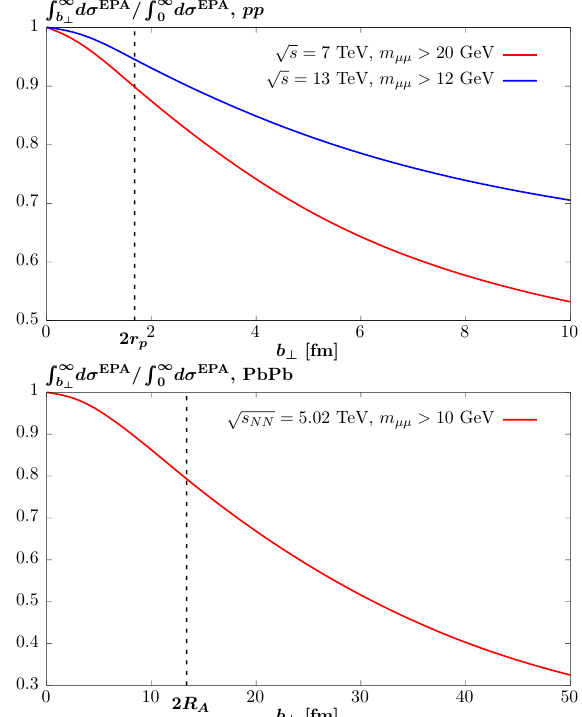
Figure 4: The pure EPA predictions for the ATLAS pp [ 14,16 ] and PbPb [ 24 ] data as a function of a lower cut on the hadron–hadron impact parameter b ⊥ , considered as a ratio to the full EPA result, i.e. integrated down to zero b ⊥ . All results apply the corresponding experimental event selection. The values of twice the proton and lead radii are